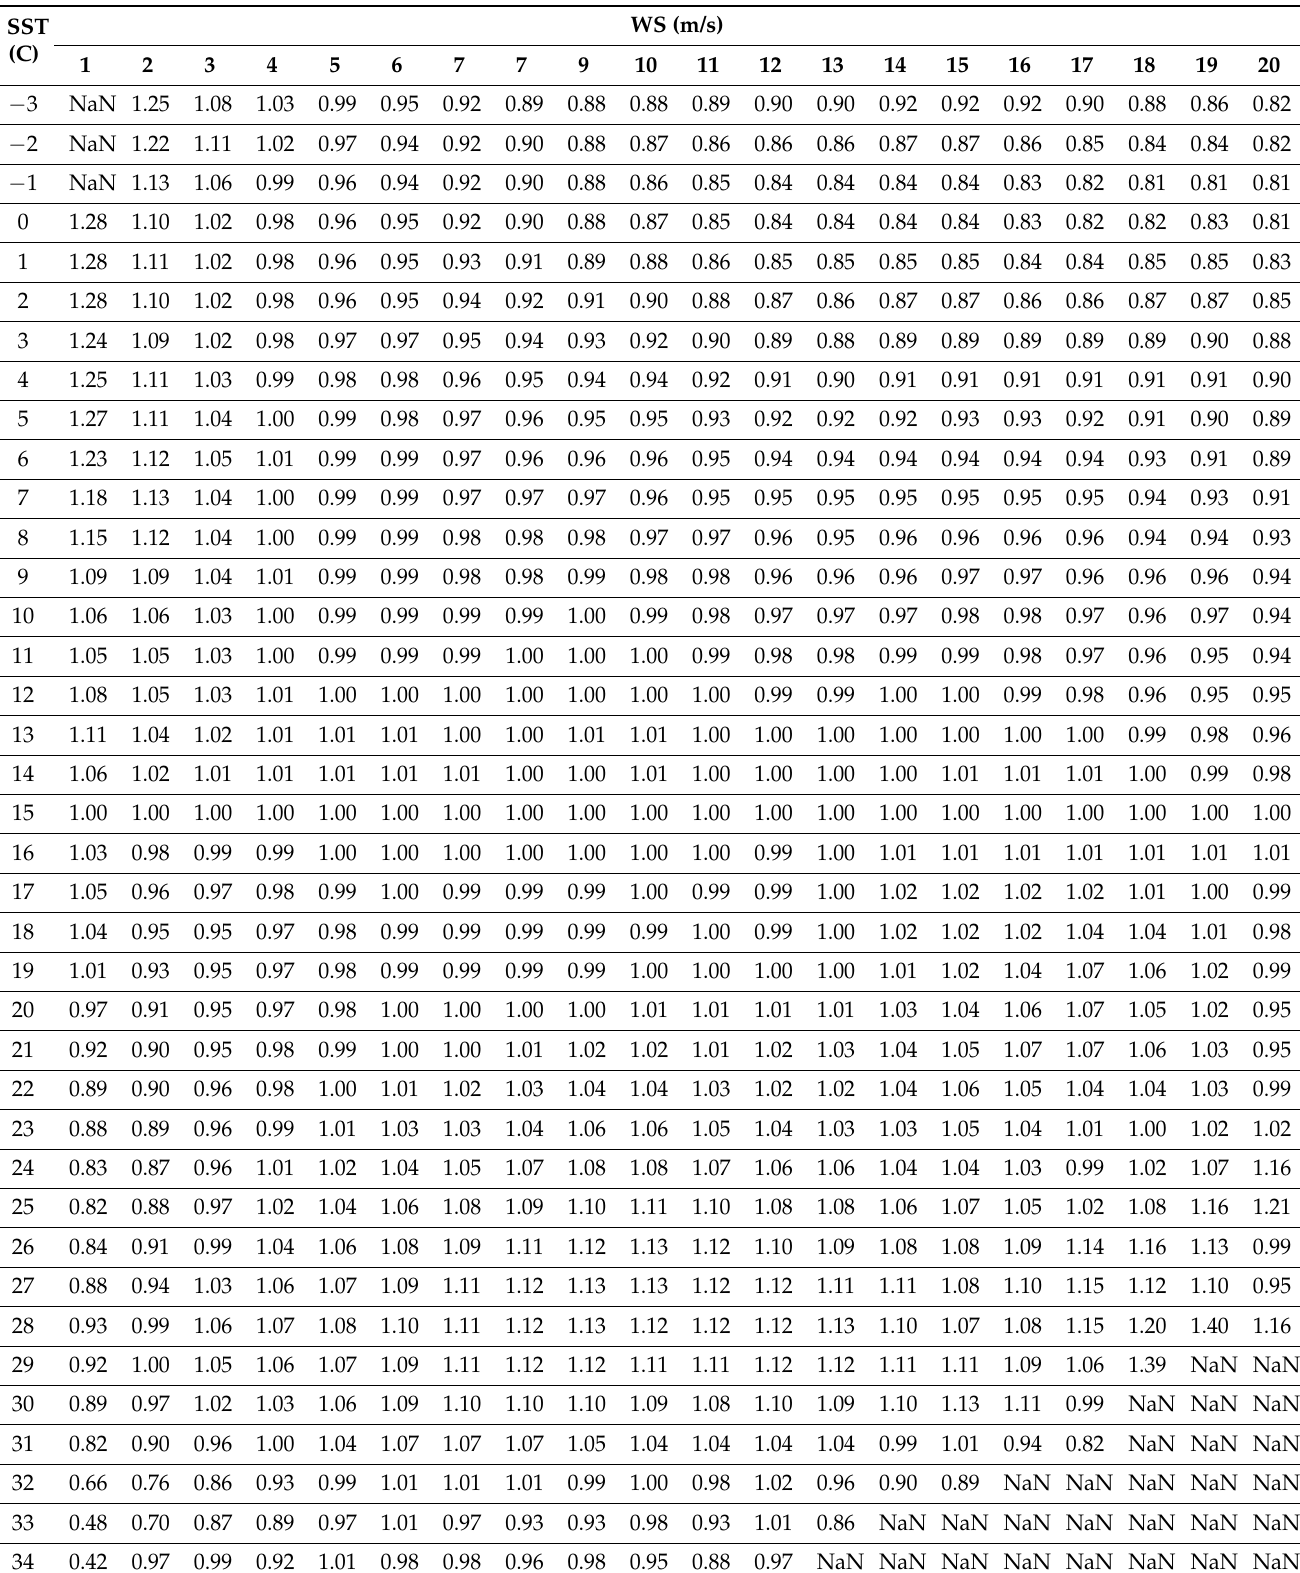
Table A6. SST correction factor (W) for Ka-band model for EIA = 18 ◦ in linear unit (Equation (8)). The bins with inadequate observations are shown as not-a-number